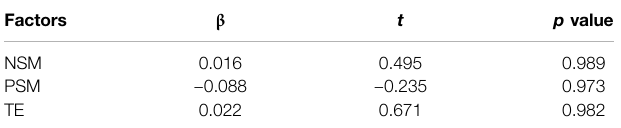
TABLE 11 | Factors excluded from the fi nal multiple regression model.